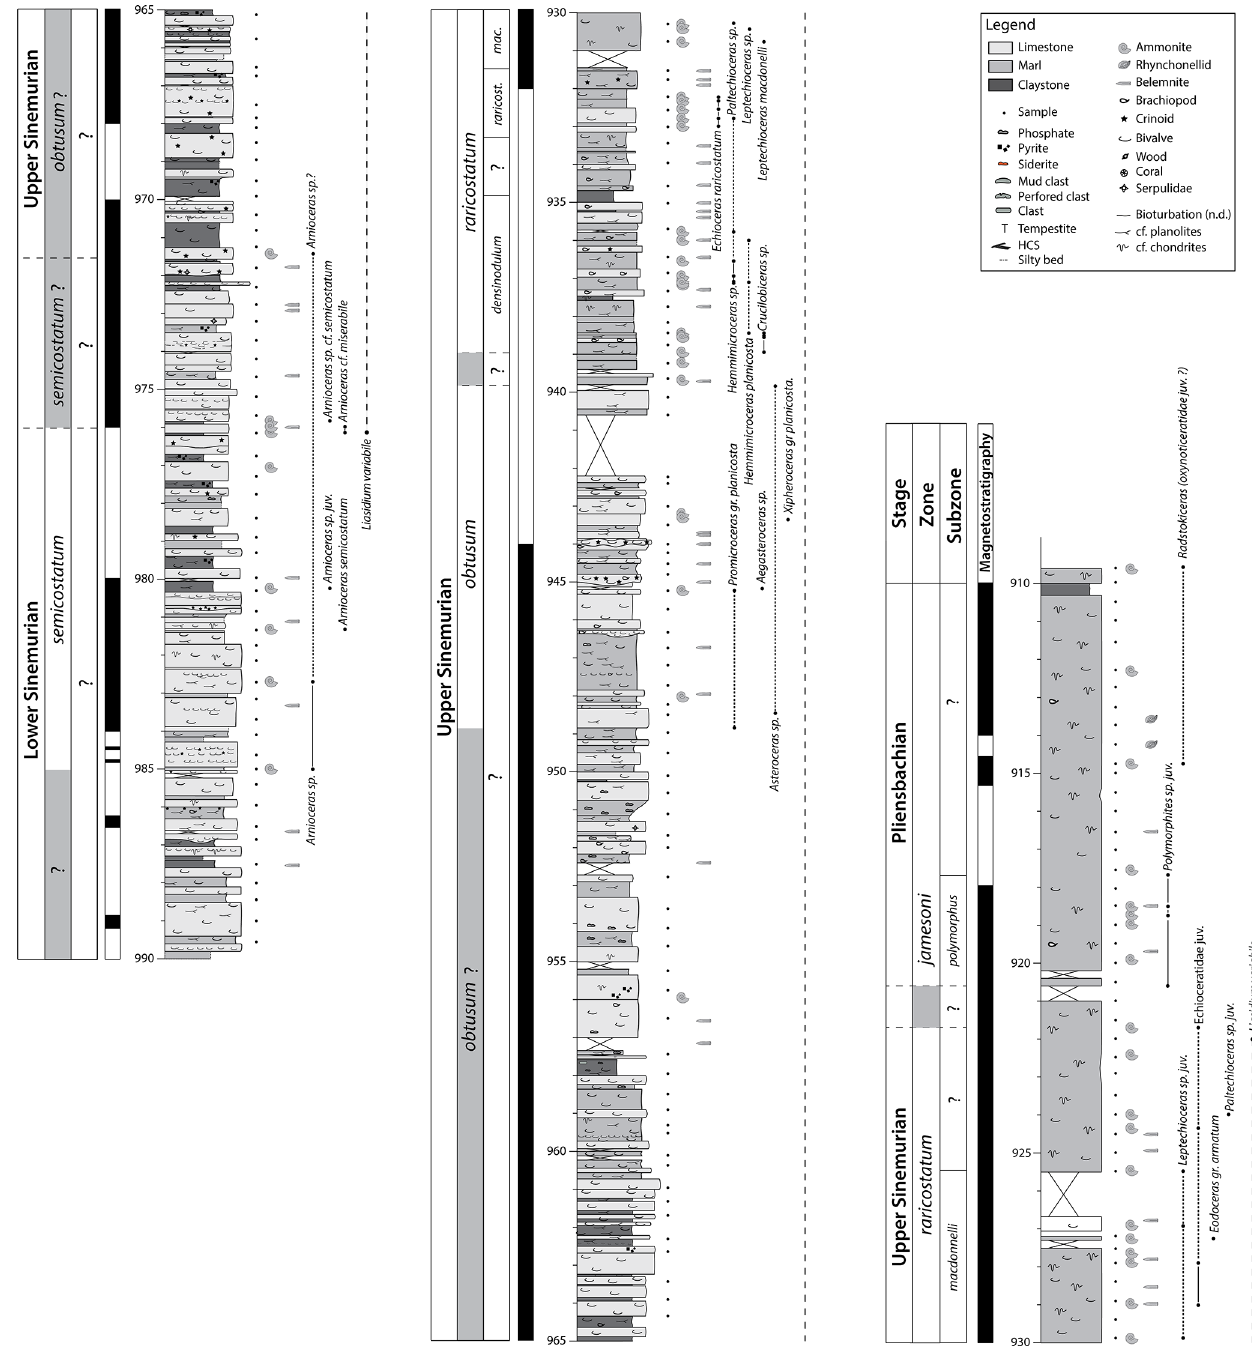
Figure 4. Detailed lithology, sampling, biostratigraphy, and magnetostratigraphy of the upper Sinemurian of the Montcornet borehole. Biostratigraphy modified from Yang et al. (1996) and Fauconnier (1995). Magnetostratigraphy from Yang et al. (1996) and Moreau et al. (2002). Gr. – group, juv. – juvenile, mac. – macdonnelli , semico. – semicostatum